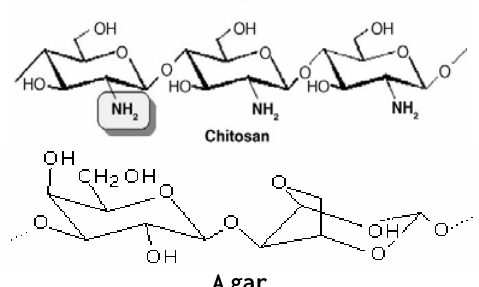
Figure 1. Chemical structures of chitosan and